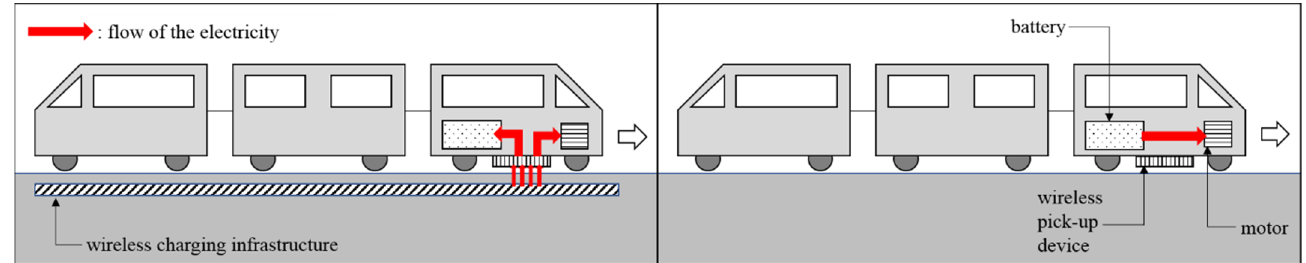
Figure 2. Electricity flow of the wireless charging electric tram system.